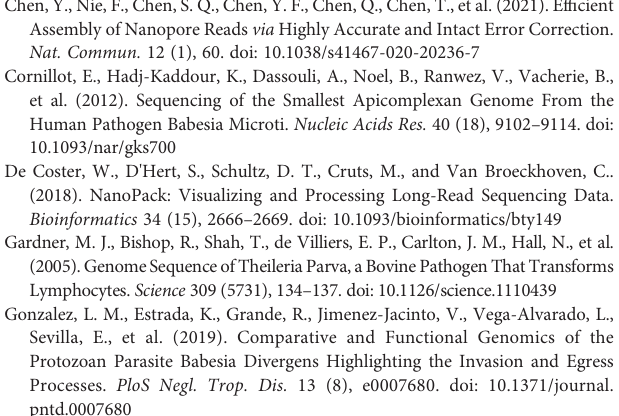
Supplementary Figure 1 | Comparison of the effect of various sequencing depths and assemblers on contig numbers in B. motasi